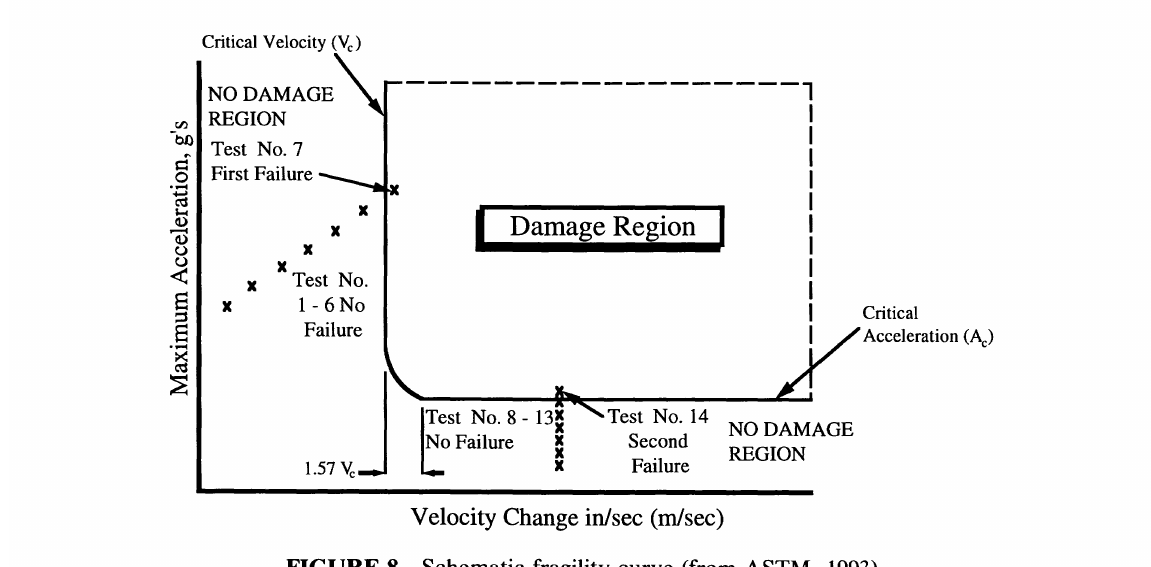
FIGURE 8 Schematic fragility curve (from ASTM,